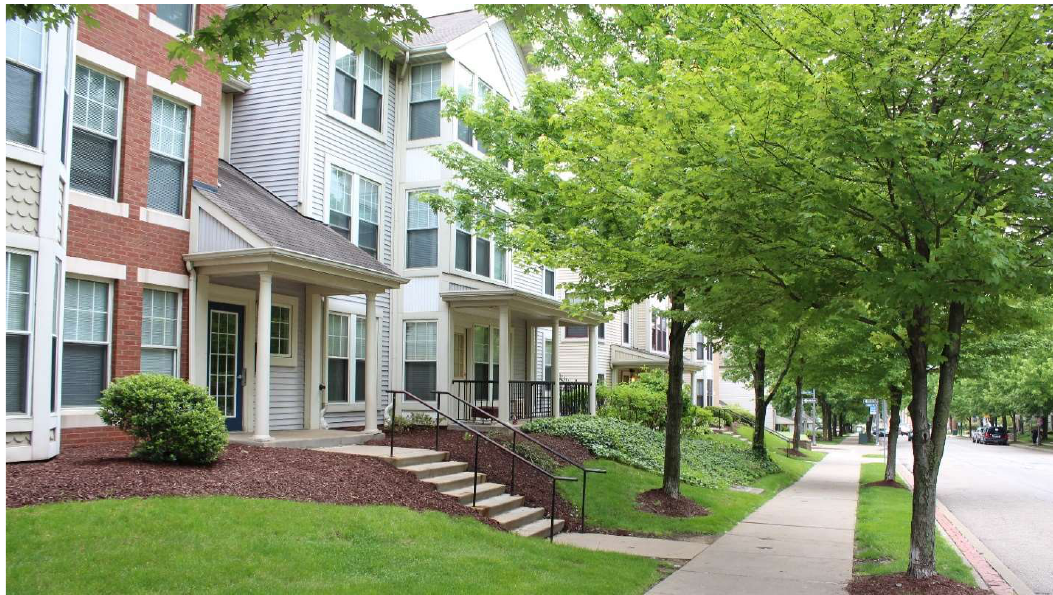
Figure 5. Mixed-income development just outside downtown Pittsburgh, PA. Photo by author.